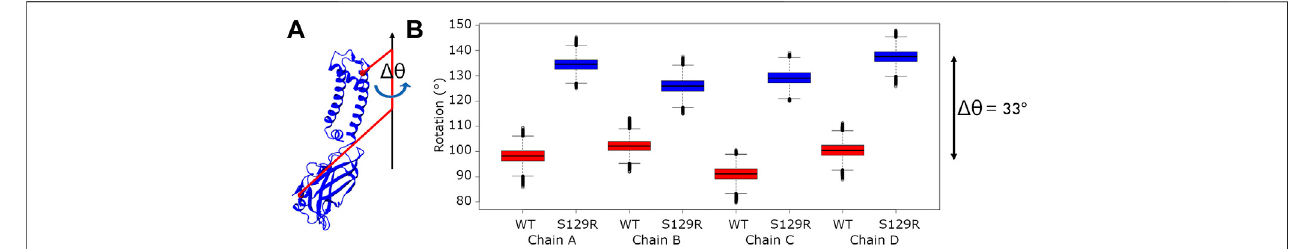
Figure 5B . The mean cytoplasmic domain rotation values are 97.95 ° (SD (cid:1) 5.13 ° ) and 131.78 ° (SD (cid:1) 5.41 ° ) for WT and mutant,